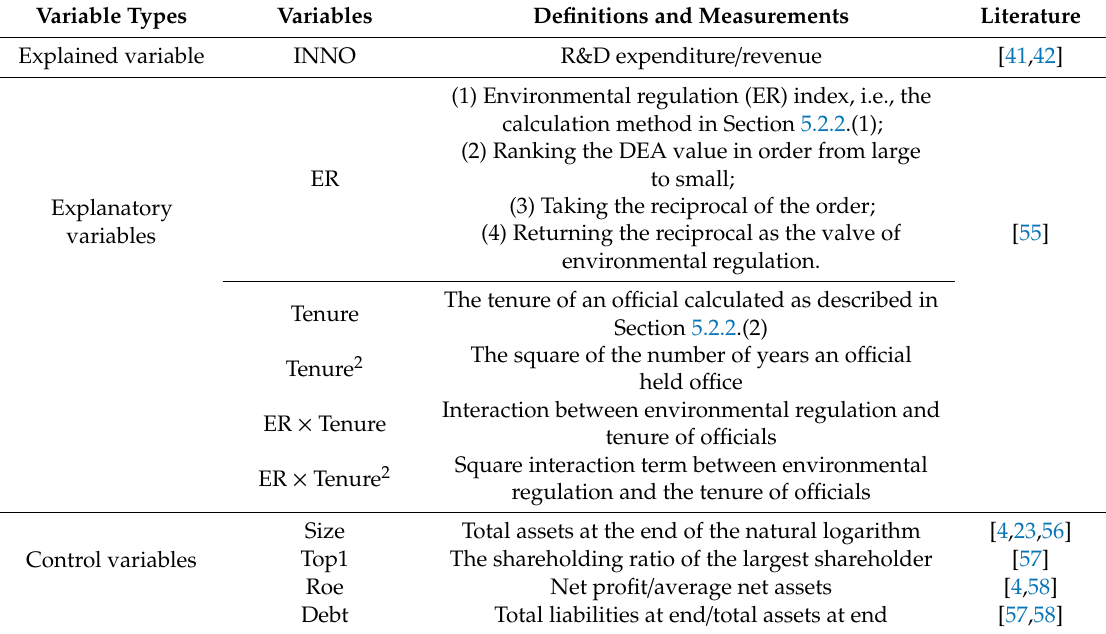
Table 1. Variable definitions. R&D—research and development